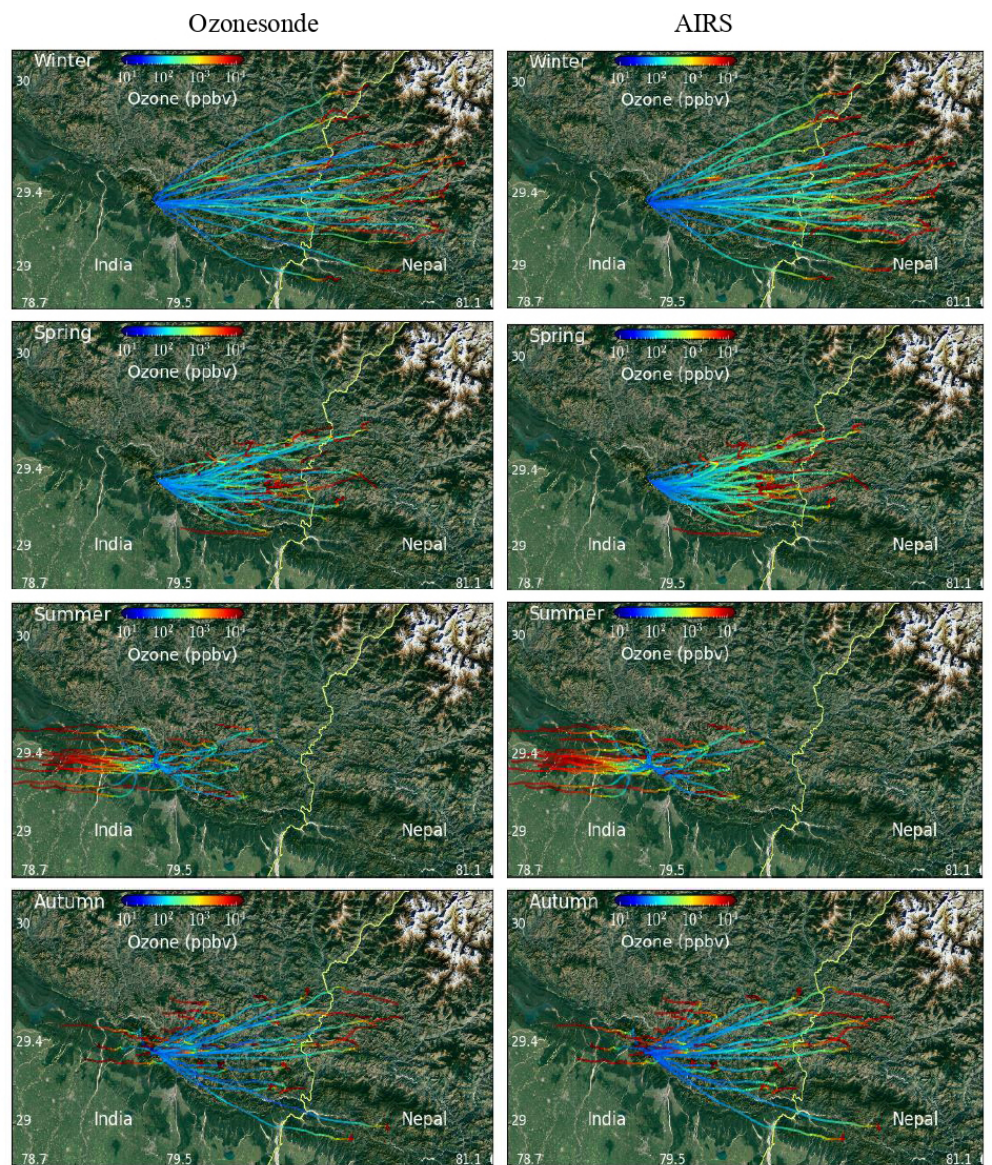
Figure 4. Spatial distribution of ozone using all ozone soundings (left) launched from ARIES, Nainital, India (© Google Earth, 2021), along with the balloon trajectories. Ozone spatial distribution from AIRS (right), following the balloon tracks, is also shown. It can be seen that the balloon reaches Nepal many times in the autumn and winter